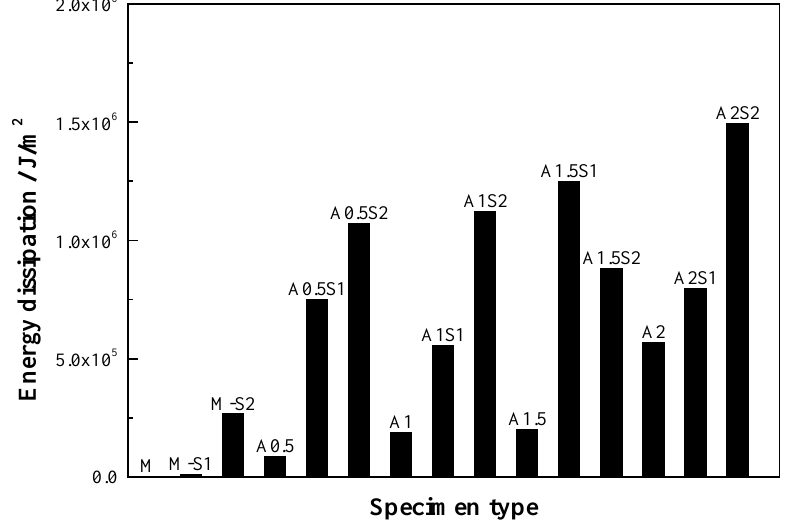
Figure 4. Comparison of energy dissipation of different types of steel grid-PVA fiber reinforced ECC specimens.